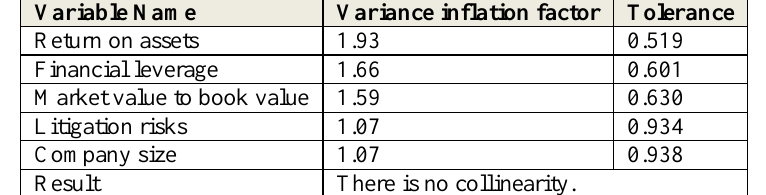
Table 11. Co-linear test of independent variables [First hypothesis (Model)]